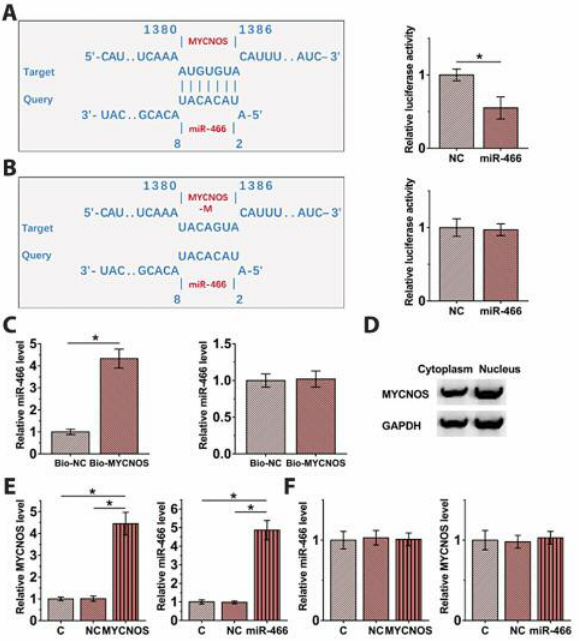
Figure 3. The interaction between MYCNOS and miR-466 failed to regulate the expression of each other. (A, left) The interaction between MYCNOS and miR-466 was predicted by IntaRNA 2.0. (A, right) Dual-luciferase activity assay was performed by co- transfecting 22Rv1 cells with MYCNOS luciferase reporter vector and NC miRNA (NC group) or miR-466 mimic (miR-466 group). (B, right) Luciferase activity was measured 48 h after transfection. MYCNOS-M (B, left) was also used to perform dual luciferase ac- tivity assay. (C) RNA pull-down assay was performed using both Bio-MYCNOS and Bio-MYCNOS-M to pull down miR-466. (D) Sub- cellular fractionation assay was used to detect the expression of MYCNOS in both nucleus and cytoplasm. (E) To further explore the interaction between MYCNOS and miR-466, 22Rv1 cells were transfected with either MYCNOS expression vector or miR-466 mimic, and the overexpression of MYCNOS and miR-466 was confirmed by RT-qPCR. (F) The e ff ects of MYCNOS and miR-466 overexpression on the expression of each other were explored by RT-qPCR. Data were expressed as mean ± SD values of three biological replicates. * p <